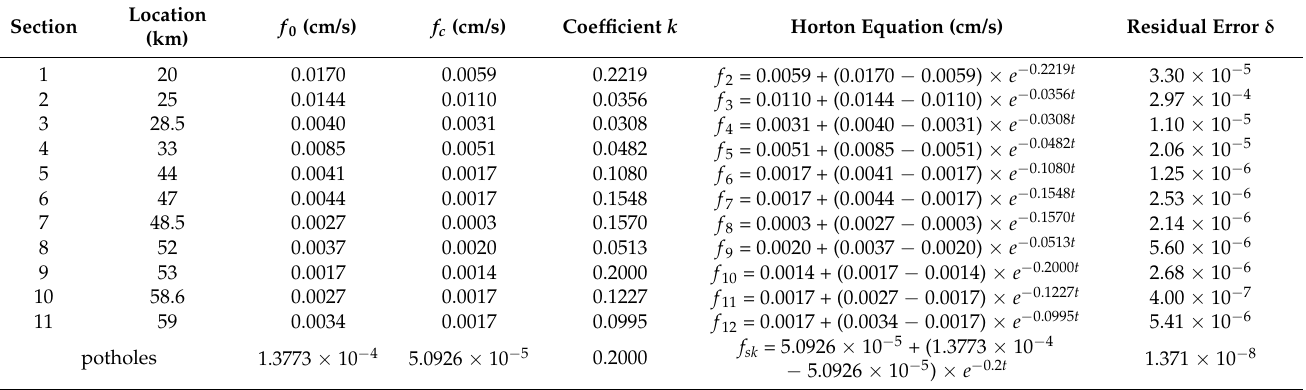
Table 2. Fitting parameters of infiltration process in the 11 sections and the